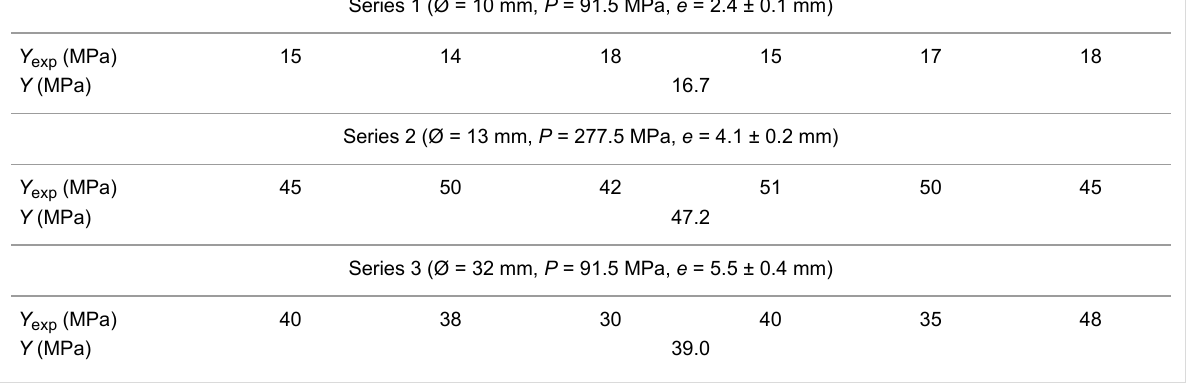
Table 2: Experimental and calculated ultimate compressive strengths for 3 series of 6 experimental tests (uniaxial compression tests). Y exp is the ex- perimental and Y the calculated ultimate compressive strengths of the pellets, respectively.